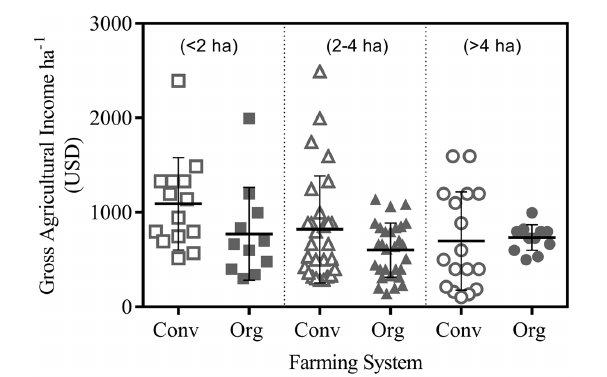
comparable across farm sizes and farming systems ( Figure 1 ). On conventional farms, median income per unit of land decreased as the land holding increased ( Figure 1 ), whereas level of income per unit of land remained unrelated to landholding of organic farmers and did not vary much among the farm